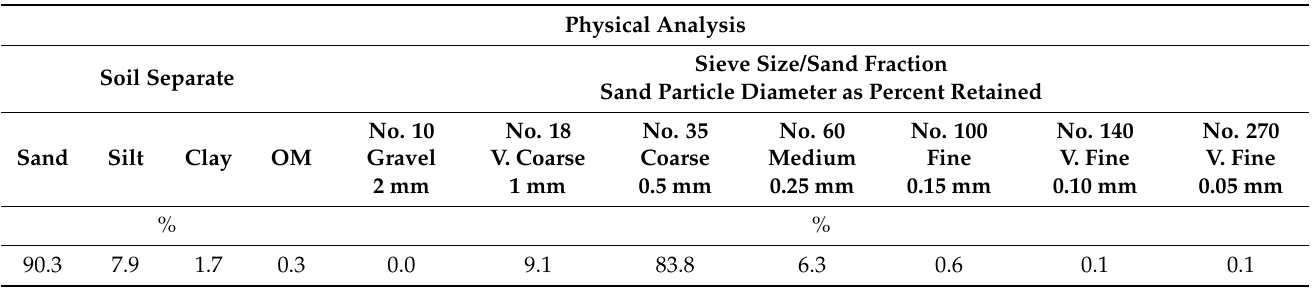
Table 1. Physical analysis of the sand root zone at the study site (1) . Physical Analysis